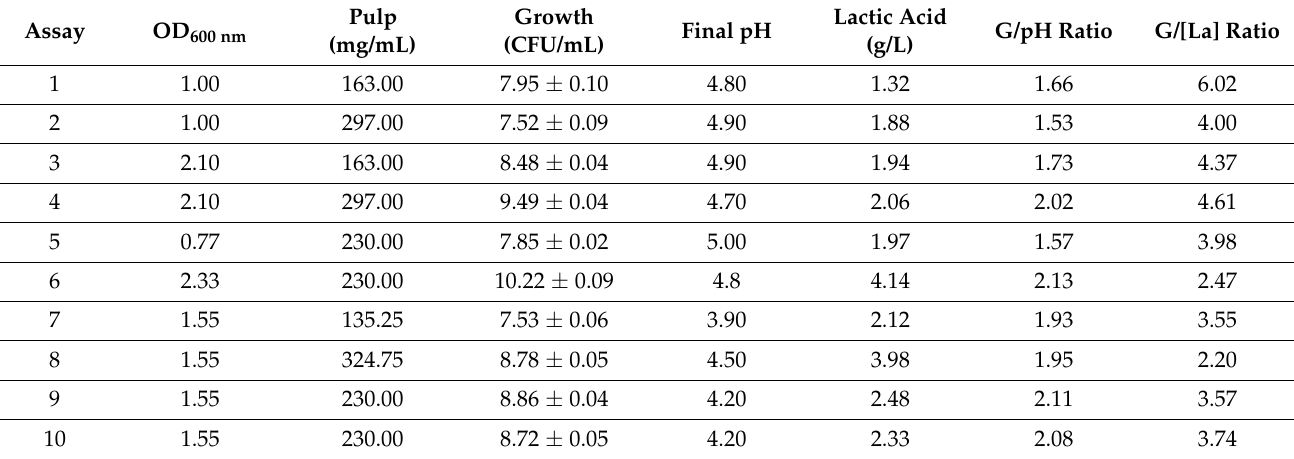
Table 3. Effects of inoculum density and pulp concentration on growth and lactic acid production by L. rhamnosus ATCC 9595.